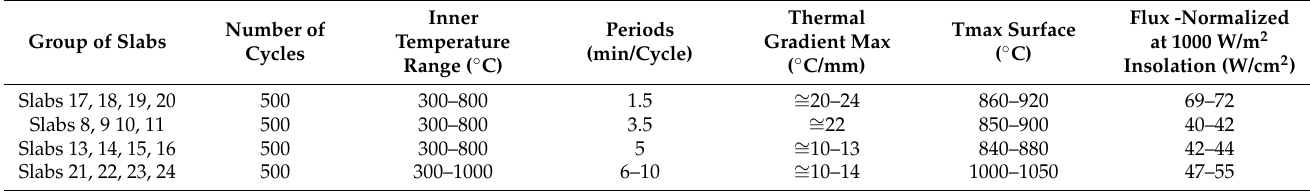
Table 3. Average values of heating and cooling rates during the solar ageing tests.